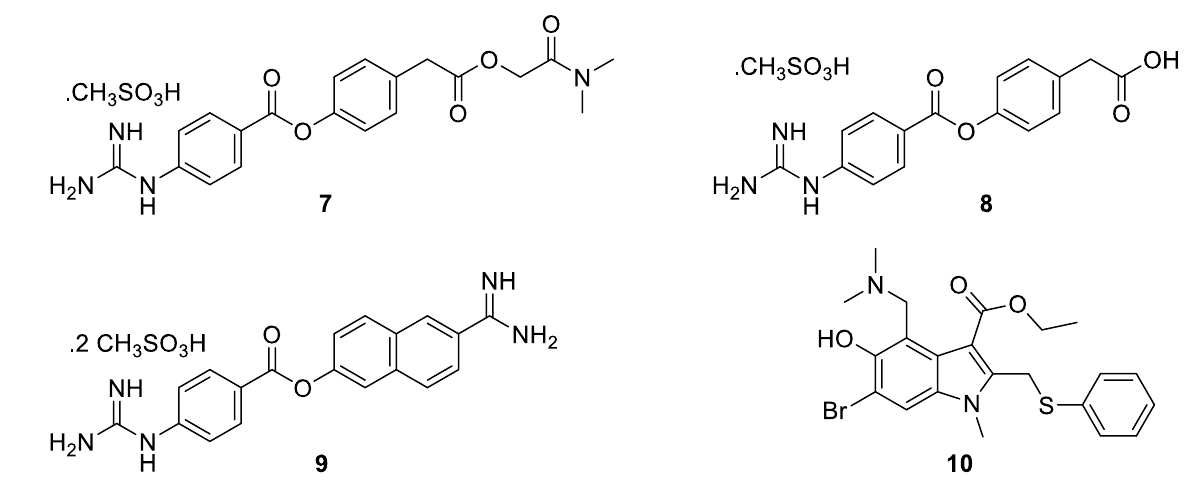
Figure 4. Chemical structure of camostat mesylate ( 7 ), its metabolite ( 8 ), nafamostat ( 9 ), and umifenovir ( 10 ).